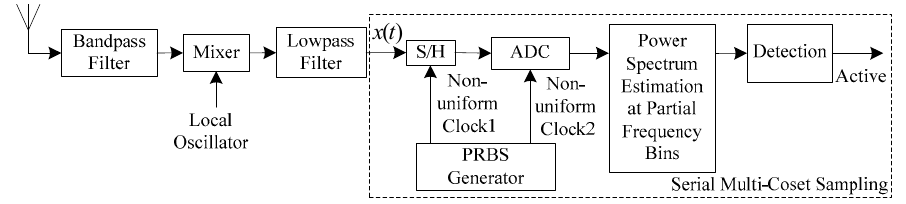
Figure 2. The block diagram of single-channel sub-Nyquist sampling.